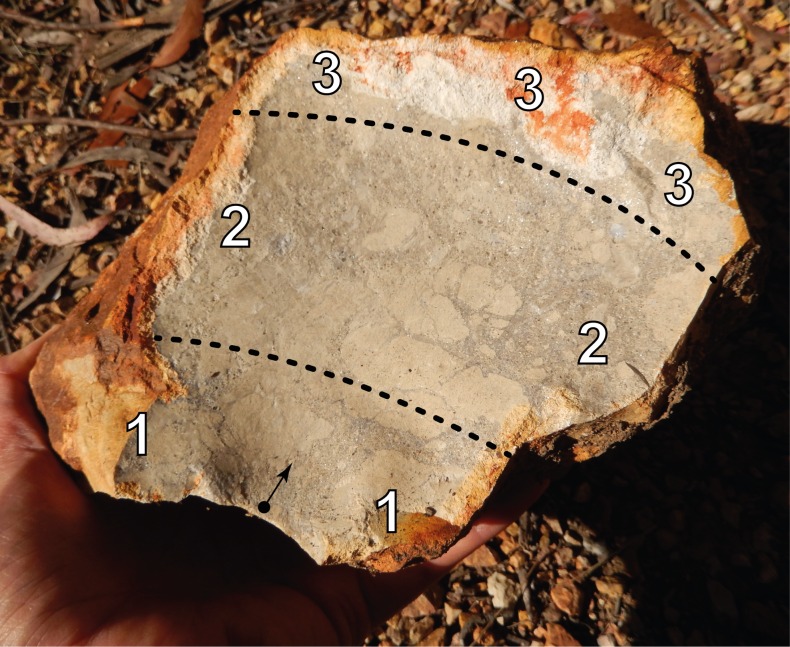
Negative scar on a silcrete cobble showing platform positions.‘Position 1’ platforms are located in a zone extending from the proximal end to 30% of the scar’s length, ‘Position 2’ are located between 30% to 80% of the scar’s length, and ‘Position 3’ platforms are located on the scar’s distal end, beyond 80% of its length. Negative scars are always concave and many of the scars produced in the experiments were markedly so. Because of this factor, and the difficulty of landing percussion blows in a concave surface, platforms were usually located within the 10% of the scar’s width extending from the scar’s edge. ‘Position 4’ platforms are cortical surfaces; ventral surfaces or dorsal scar remnants from core reduction on dorsal surfaces of flake blank cores; or small core scar remnants that could not be classified into the other platform types.